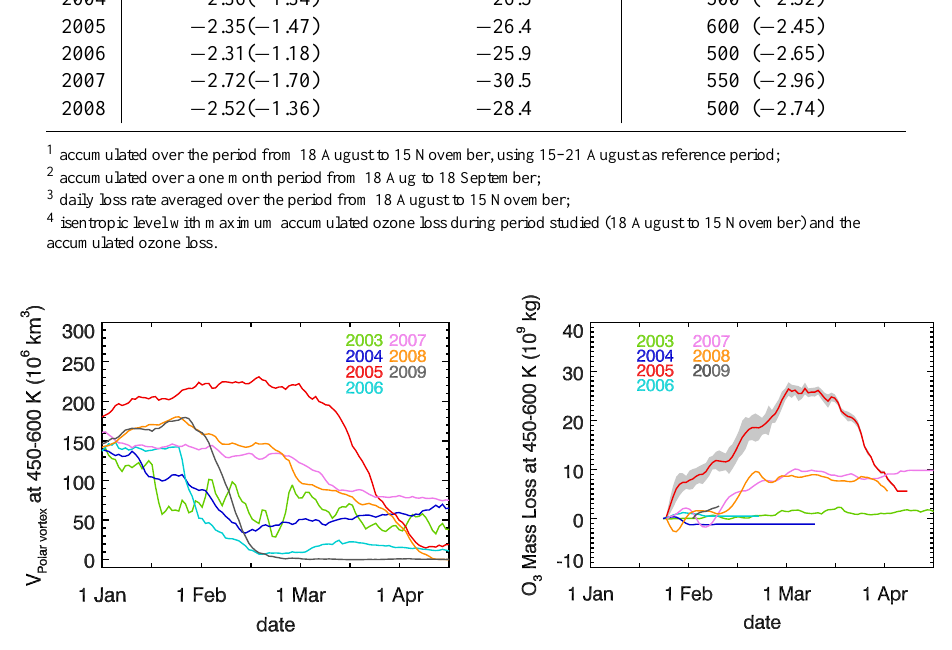
Fig. 8. Time evolution of the polar vortex volume (left panel), and the estimated ozone mass loss inside the vortex (right panel) between the 450K and 600K isentropic levels in the Arctic winter stratosphere. Note that the isentrope range considered here (450 - 600 K) includes both halogen driven ozone loss below about 550 K as well as NO x driven ozone loss near 600 K occurring near the end of spring (see Fig. 5).